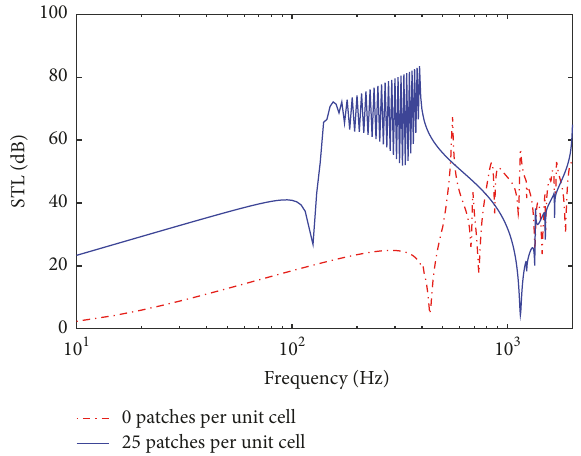
Figure 11: Comparison of the STL between the contrast structure with no piezoelectric patches and the research sandwich structure is flexibly connected with 25 piezoelectric patches in each unit cell.